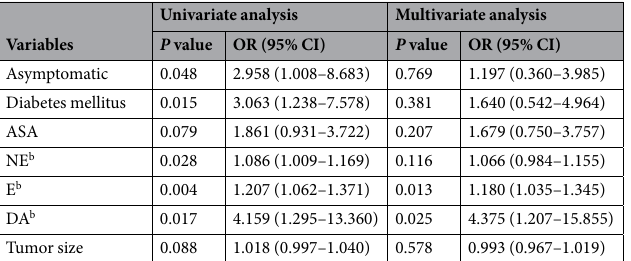
Table 4. Uni- and multivariate analyses for predictors of prolonged hypotension. ASA, American Society of Anesthesiologists Physical Status Classification System; NE, norepinephrine; E, epinephrine; DA, dopamine; OR, odds ratio; CI, confidence interval. b Multiple of the normal reference upper limit